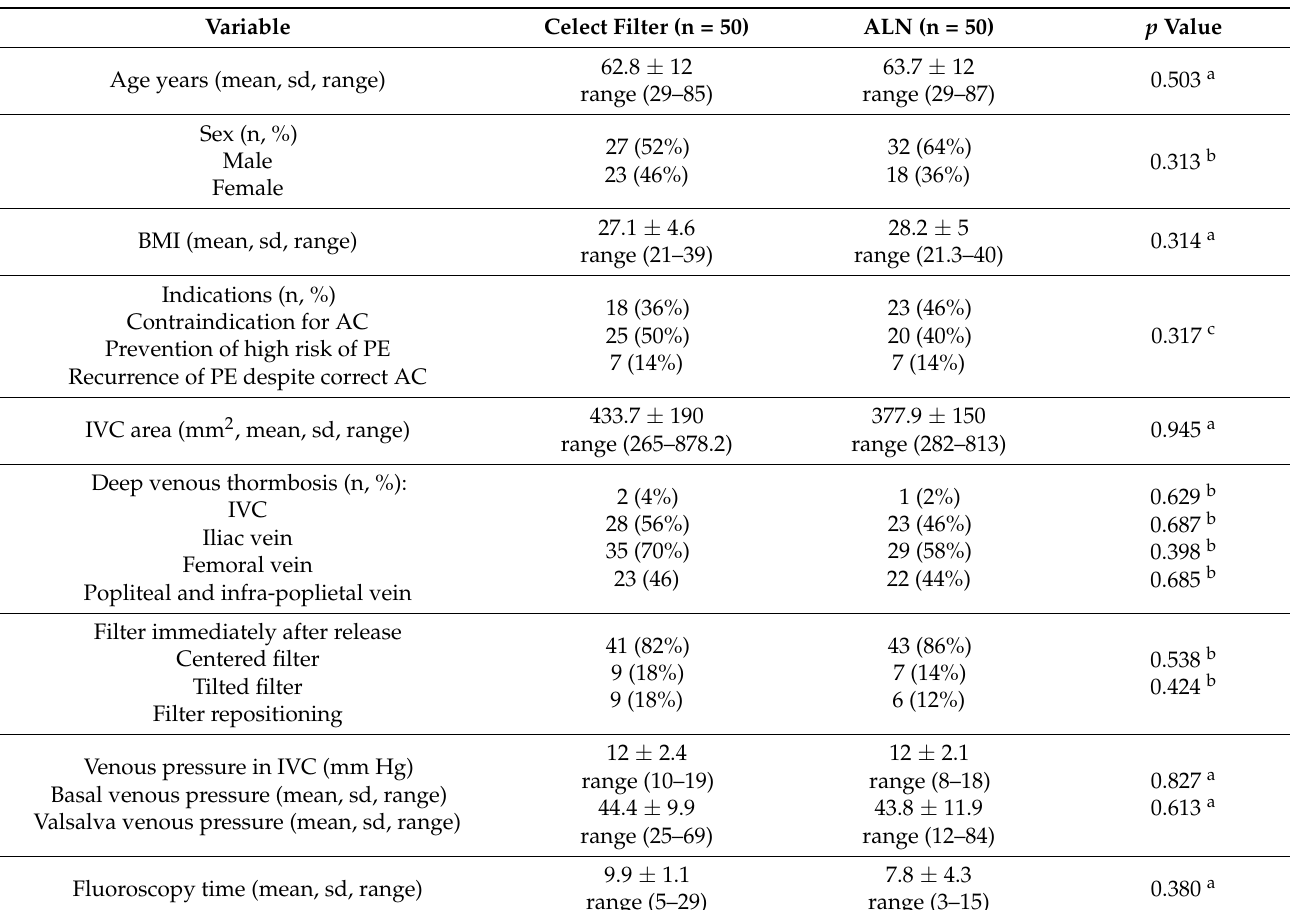
Table 2. Inclusion and exclusion criteria. VTD: venous thrombosis disease, AC: anticoagulation,